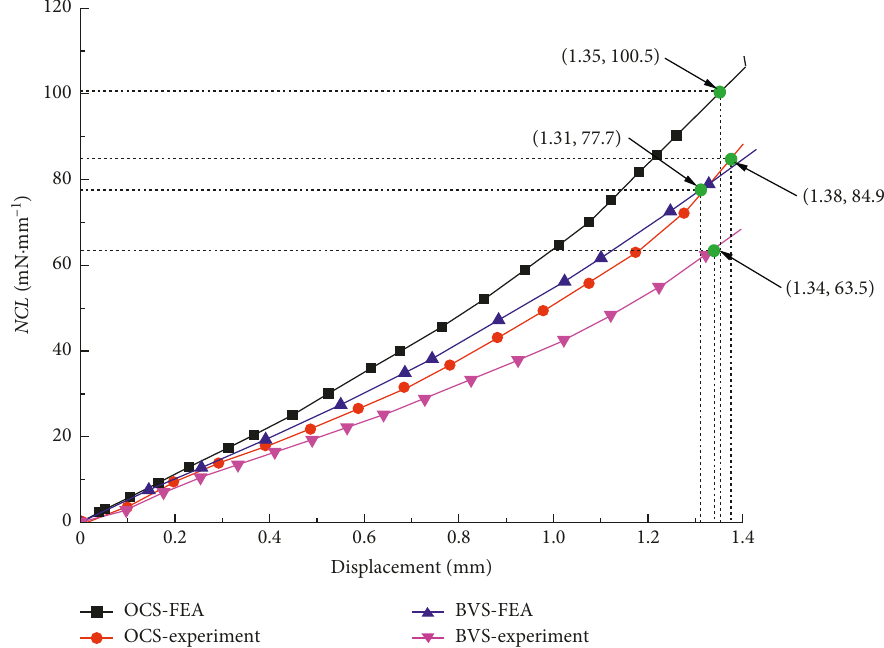
Figure 19: Normalized compressive load-displacement curves of the OCS and BVS during in vitro experiments and